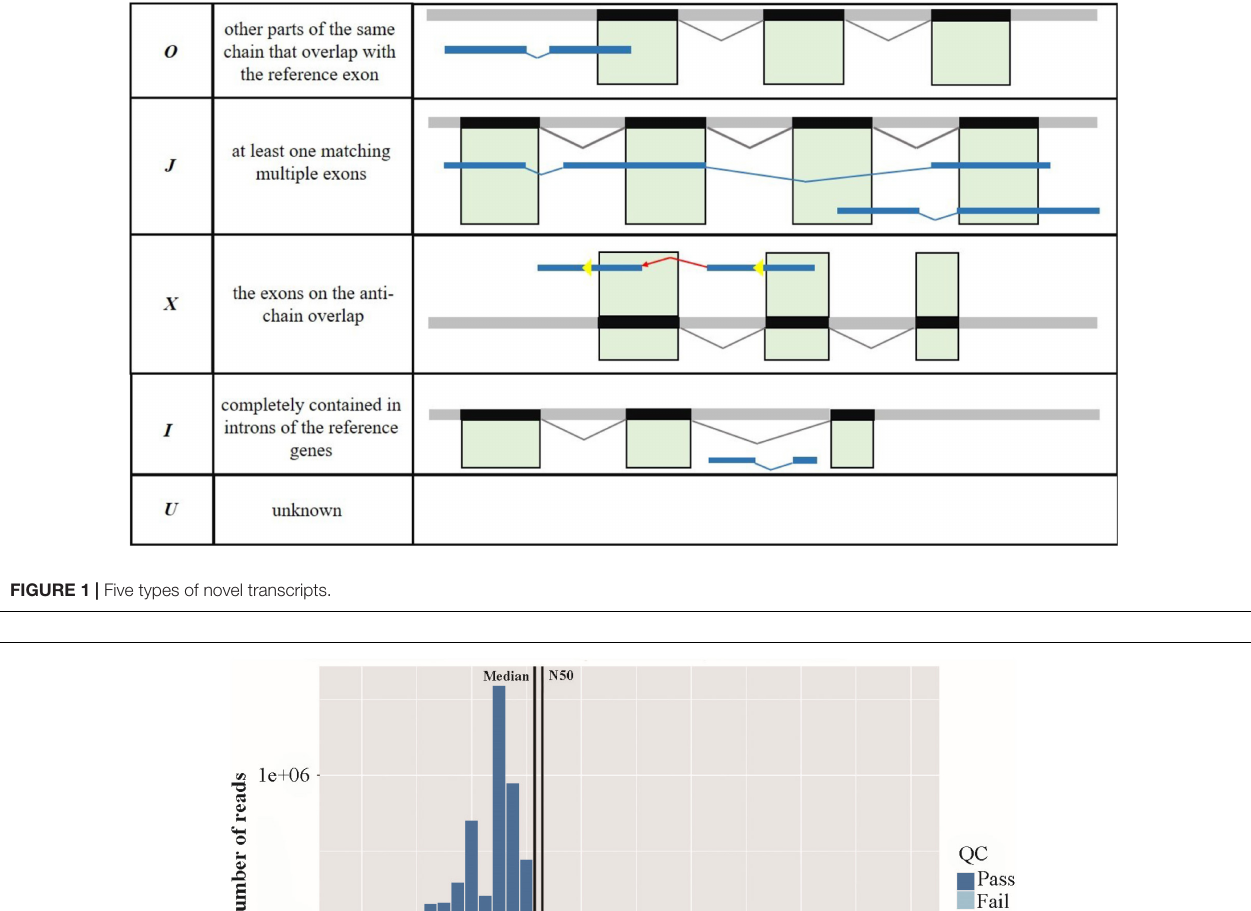
FIGURE 2 | Histogram showing the length distribution of sequencing reads across quality passing sequences.